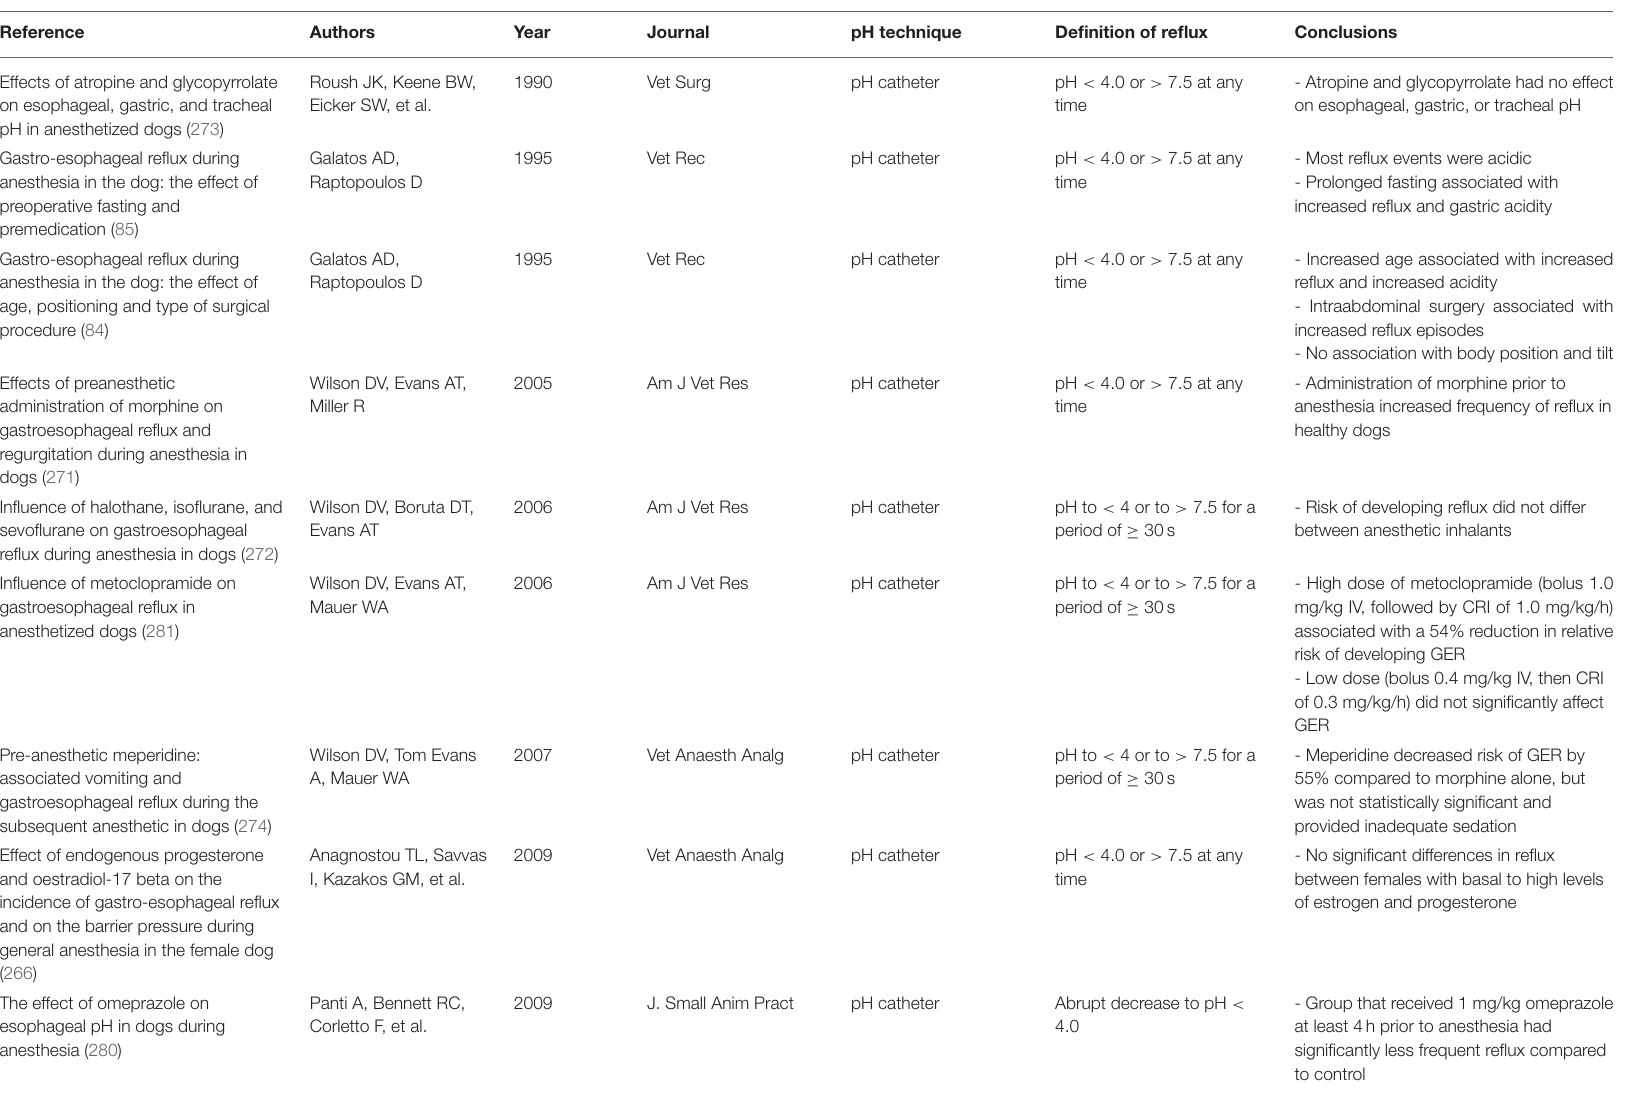
TABLE 3 | Manuscripts assessing gastroesophageal reflux in dogs using pH